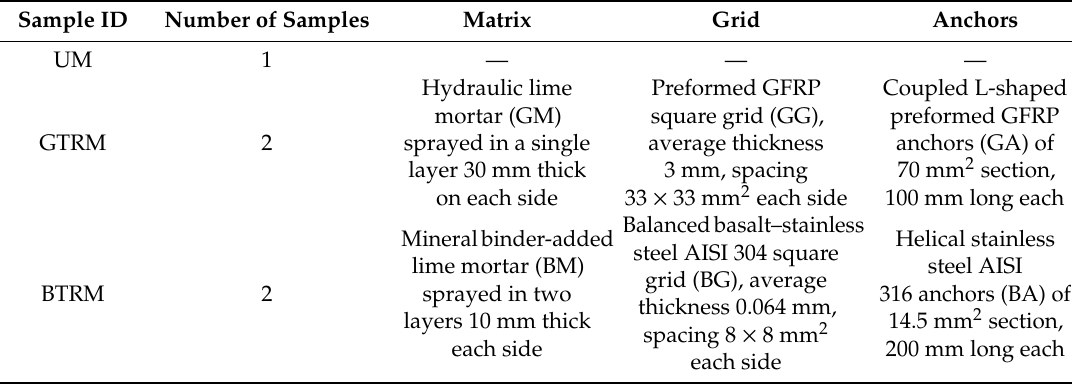
Table 1. Strengthening configurations of the specimens.